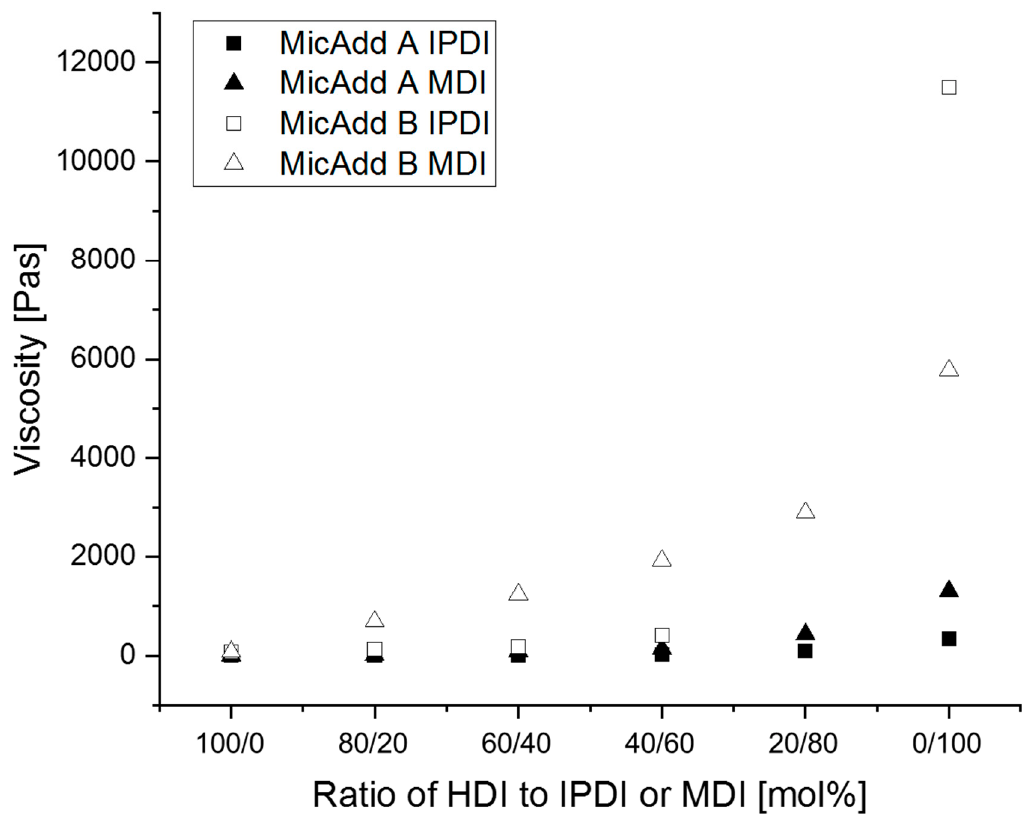
Figure 2. Change of viscosity by altering ratios of diisocyanates in the reaction mixture.